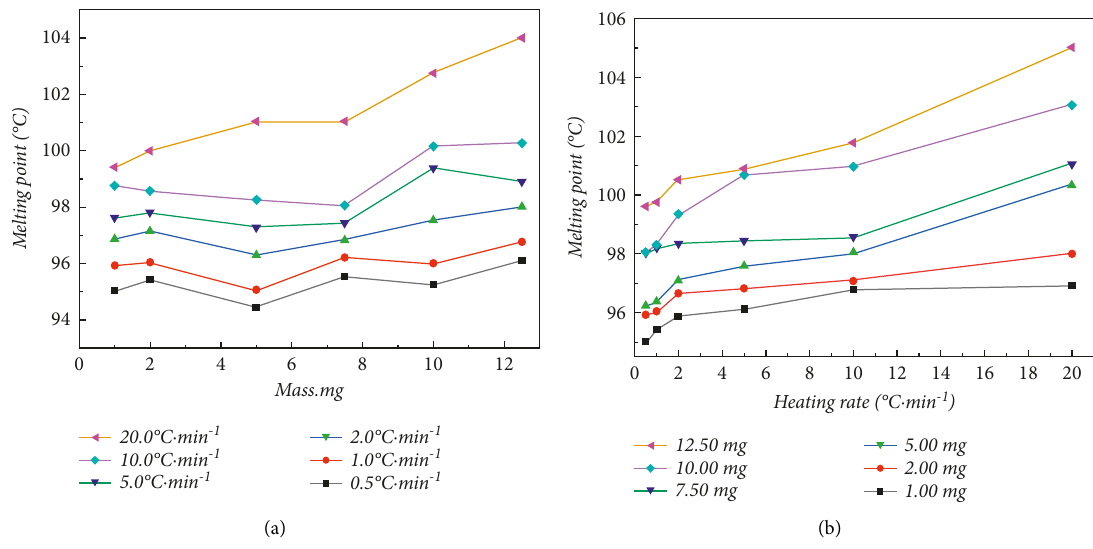
Figure 4: The initial melting point at different mass points at different heating rates. (a) The results of melting point determination for different masses of samples at the same heating rate. (b) The results of melting point determination for different heating rates of samples at the same mass.